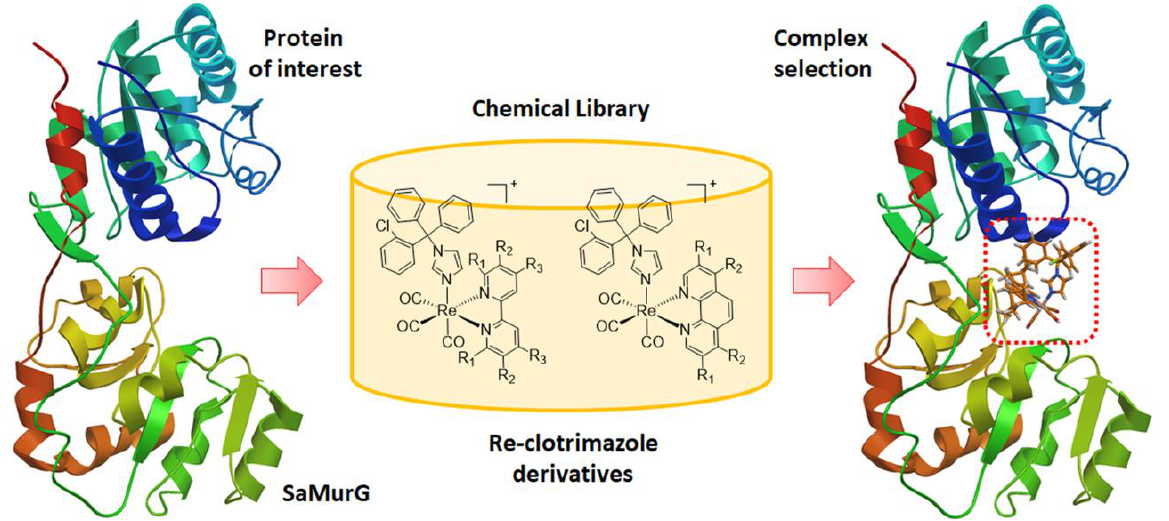
Figure 2. Schematic diagram of the conventional docking approach used to identify ‘hit’ complexes of Re-ctz derivatives.